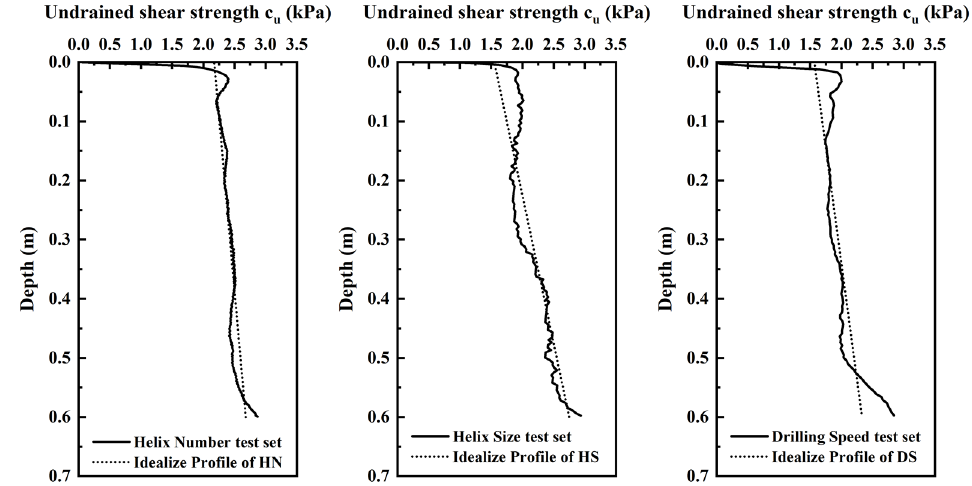
Figure 5. Undrained shear strengths of kaolinite clay in each bed box.